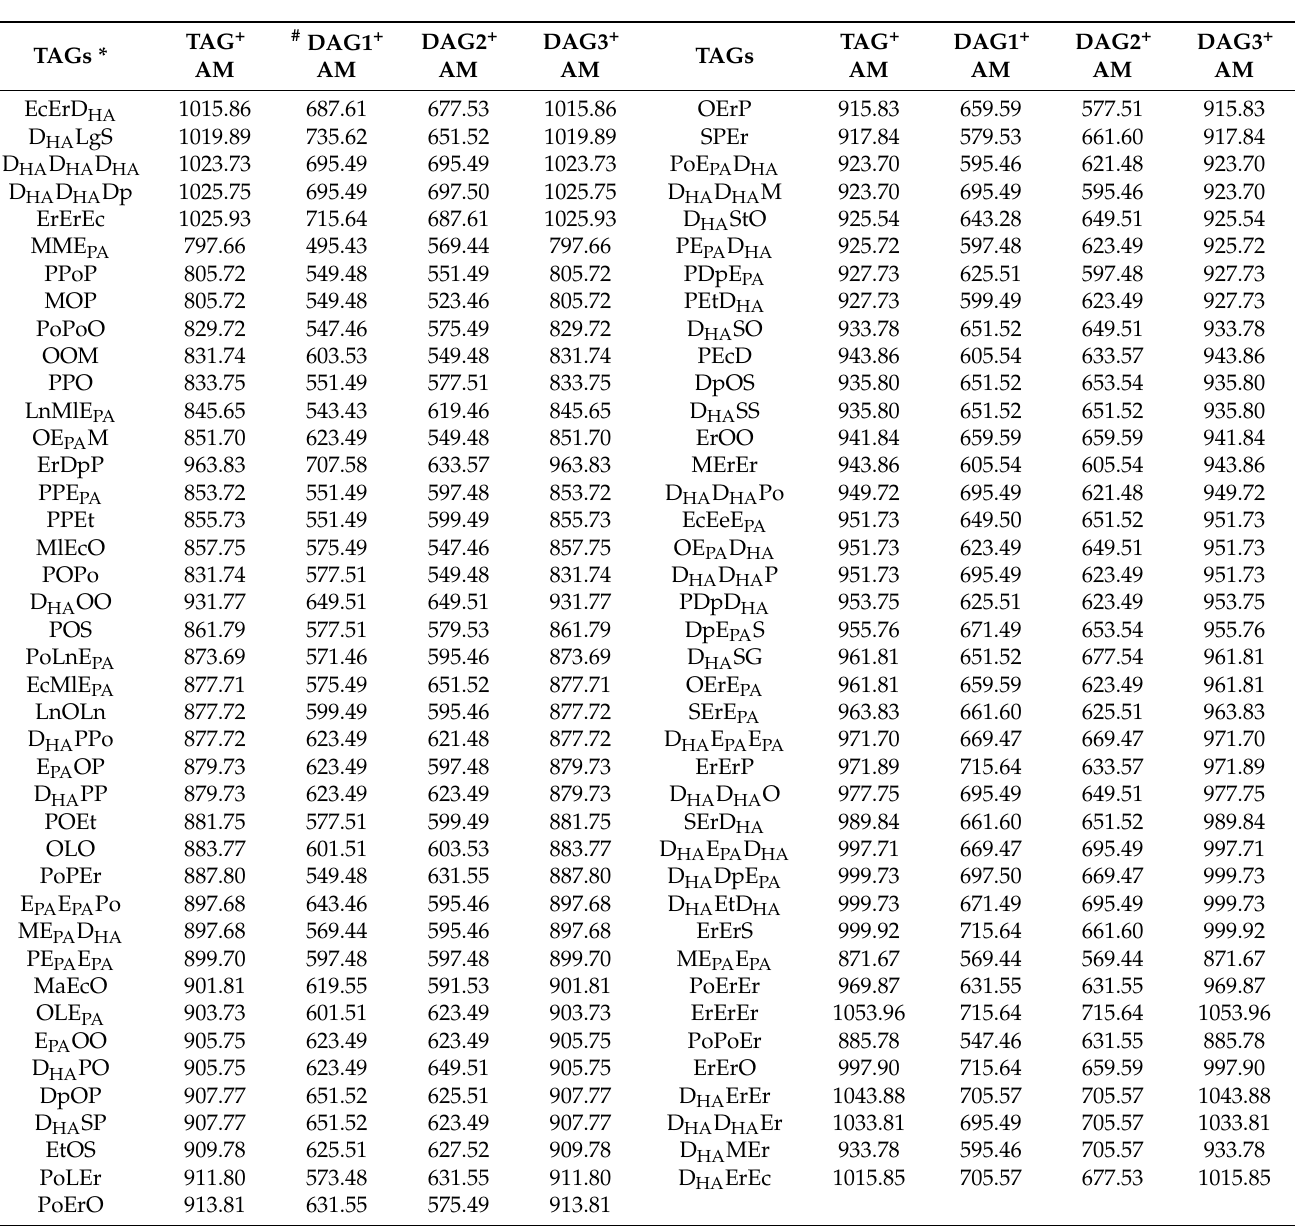
Table 2. Triglycerides tentatively identified based on the accurate masses (AM) of quasi molecular and diglyceride protonated fragment ions. The acids position is only nominal (not determined by MS/MS